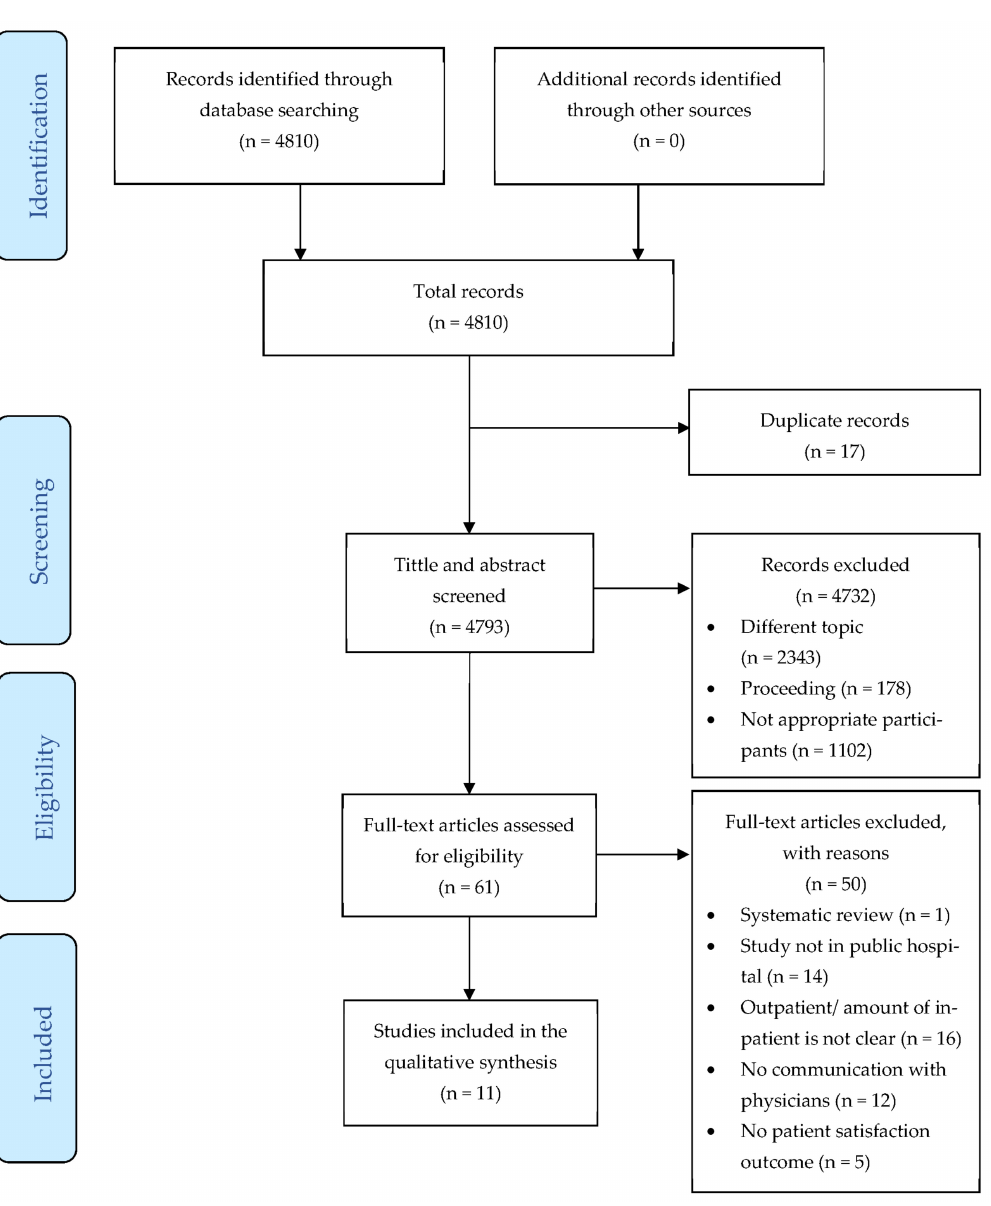
Figure 1. PRISMA Flow